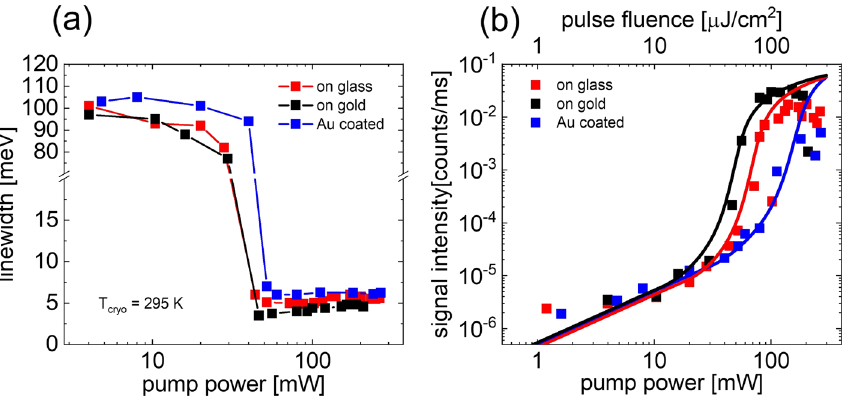
Figure 7. ( a ) Linewidth versus pump power extracted from the lasing spectra in Fig. 6 of a single GaAs NW on glass (red squares), on Au film (black squares) and from an Au coated NW (blue squares) at T cryo = 295 K. ( b ) L – L plots obtained from lasing spectra in Fig. 6. The black, red, and blue lines show calculated L – L